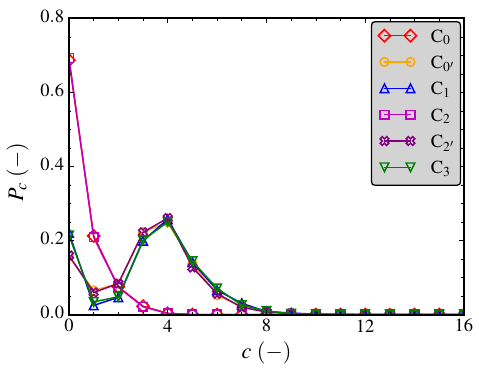
Figure 4: The connectivity P c of the contact network in the post-liquefaction cycle C.